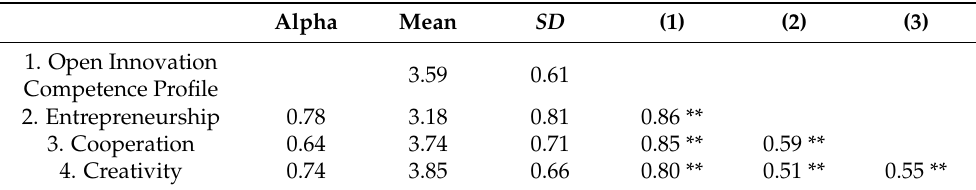
Table 2. Descriptive